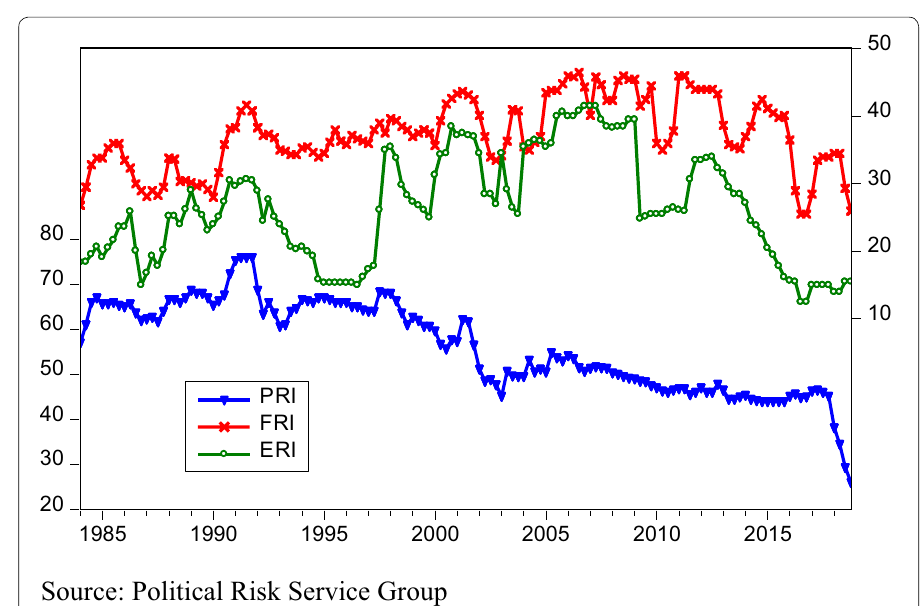
Fig. 1 Economic risk, financial risk and political risk in Venezuela (source: Political Risk Service